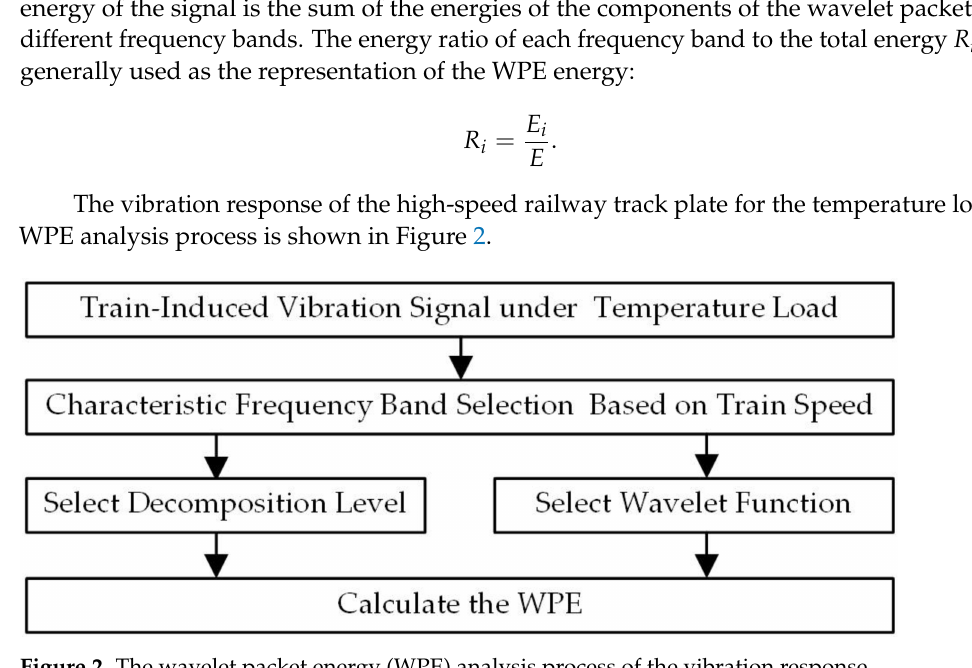
Figure 2. The wavelet packet energy (WPE) analysis process of the vibration